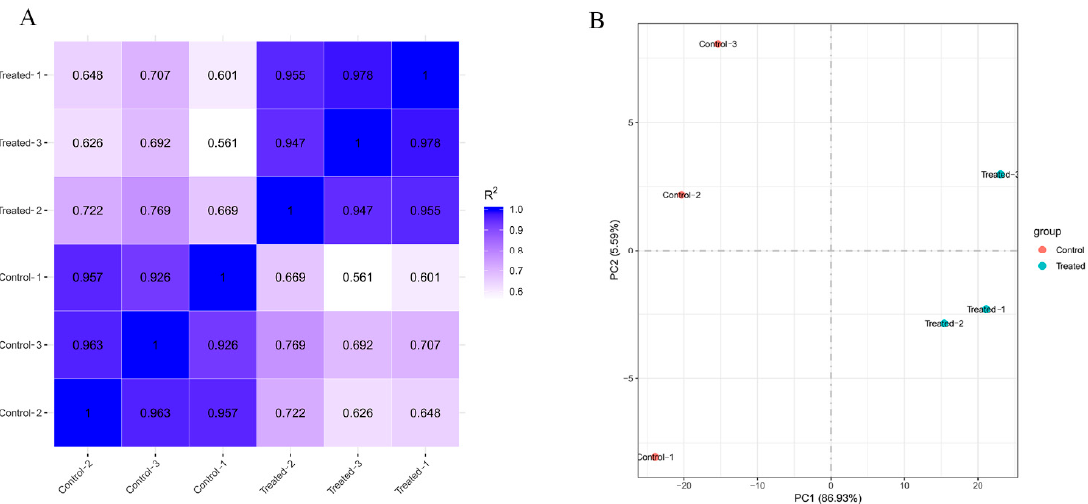
Figure 1. Correlation analysis of samples in the treated group and the control group. ( A ) Pearson correlation between samples. ( B ) Principal component analysis (PCA) based on FPKM.